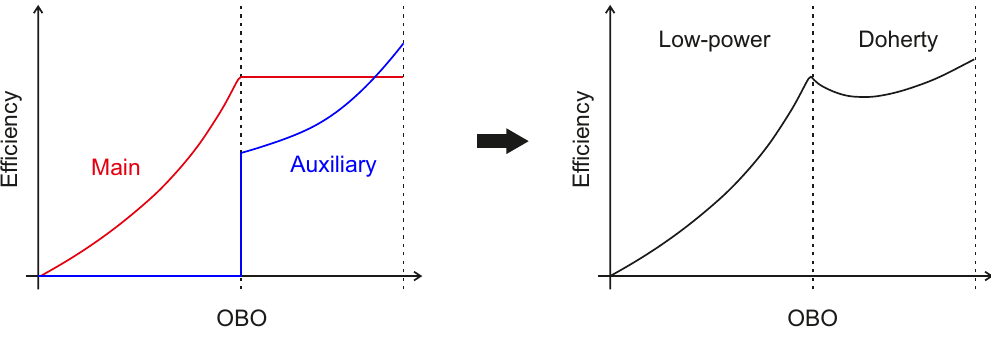
Figure 5. Simplified equivalent output section of a Doherty Power Amplifier (DPA).